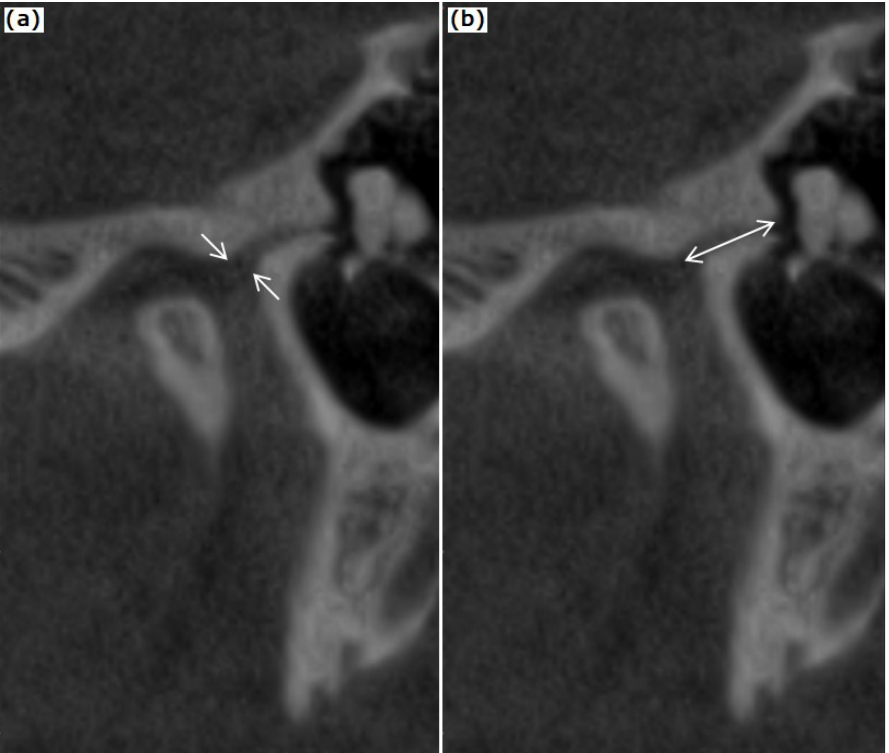
Figure 3. Measurements of petrotympanic fissure: ( a ) largest width (diameter); ( b ) length. Malleus position was assessed related to the opening of PTF in the tympanic cavity on the oblique reconstructed sagittal images on the long condyle axis. The malleus posi- tion was quantified by measuring the shortest distance from the malleus head to the teg- men tympani and the petrotympanic fissure.